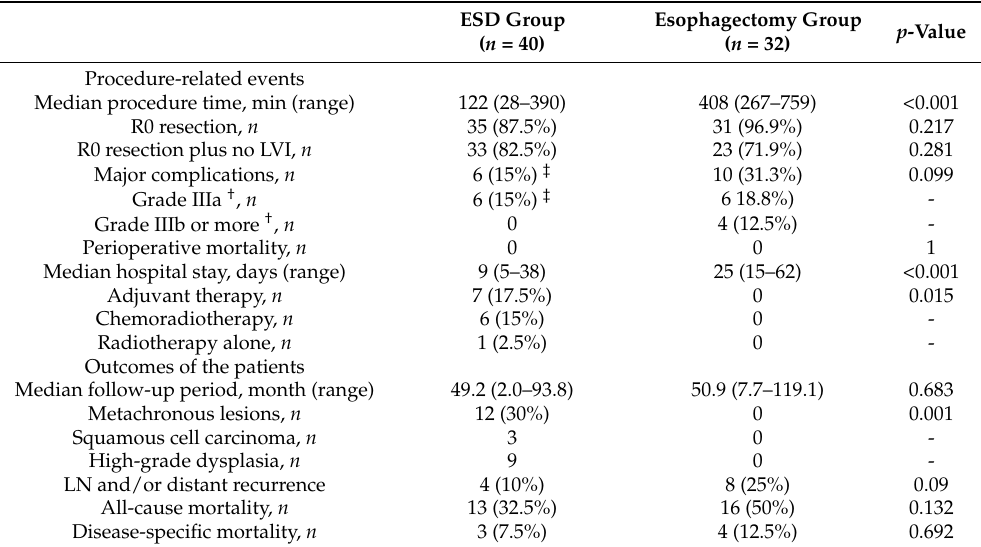
Table 2. Procedure-related events and outcomes of the